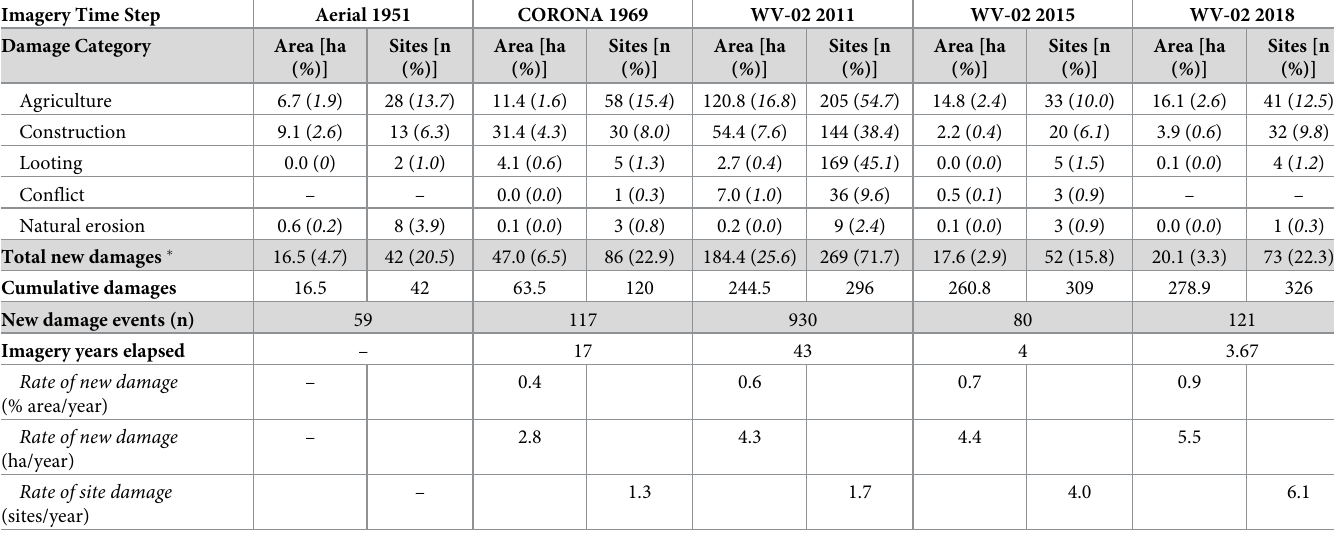
Table 2. Archaeological site damage through time. The amount of newly damaged sites and site areas, percentages, and rates of damage for each imagery time step. The percentage values are italicised in parenthesis. �